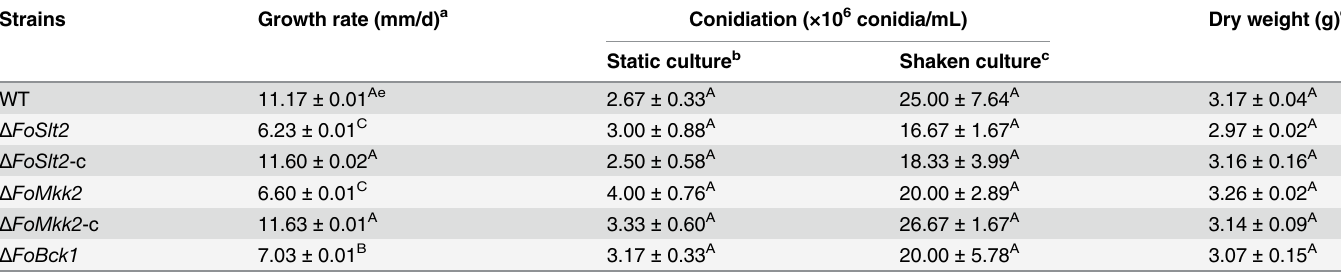
Table 1. Comparison of hyphal growth rate, conidiation and biomass among mutants and WT of FOC.